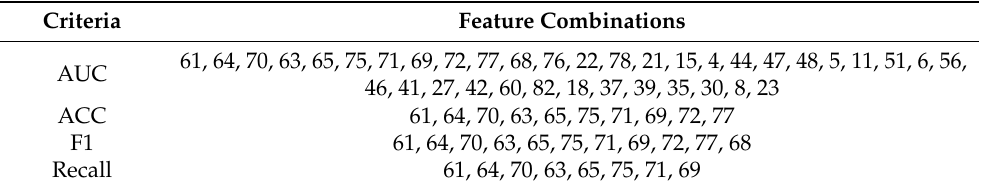
Table 3. Feature combination by SFS.